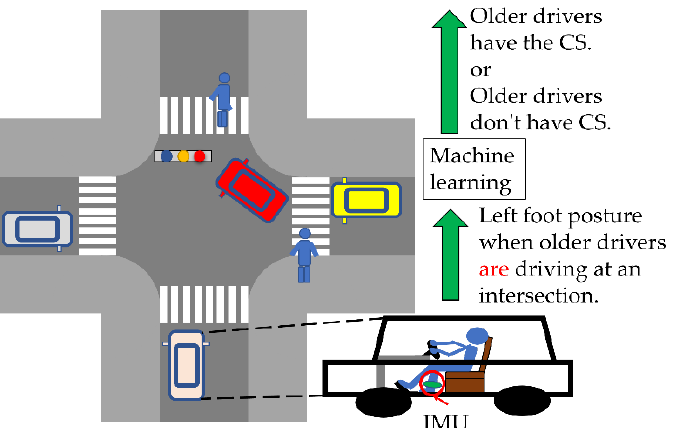
Figure 2. The coping skills prediction (CP) system, in which machine learning predicts coping skills from the left foot movements when an elderly driver drives at an intersection on a public road.